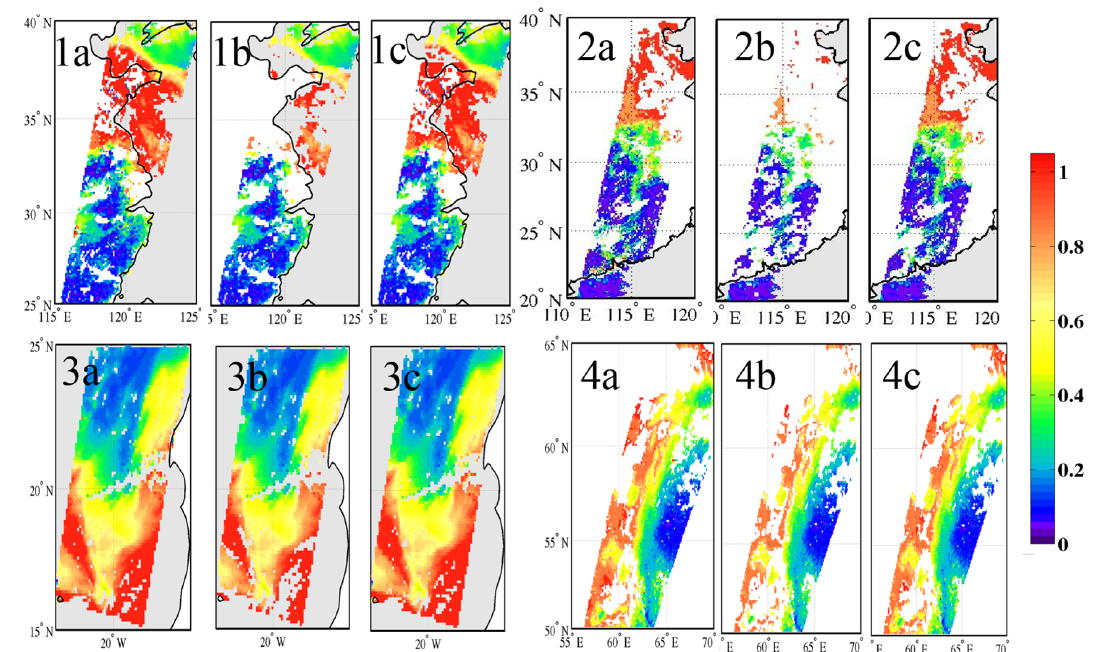
Figure 8. Example of retrieval scenes with high AOD. Upper row: over China on 3 August 2010 (case 1) and 24 July 2010 (case 2), lower row: Saharan dust outbreak on 12 March 2006 (case 3) and Siberian biomass burning episode on 1 August 2010 (case 4). For each of these cases we show (a) AOD retrieved with ADV/ASV, (b) AOD after application of the existing CPP and (c) AOD after application of the improved CPP. For orbit details, see Table